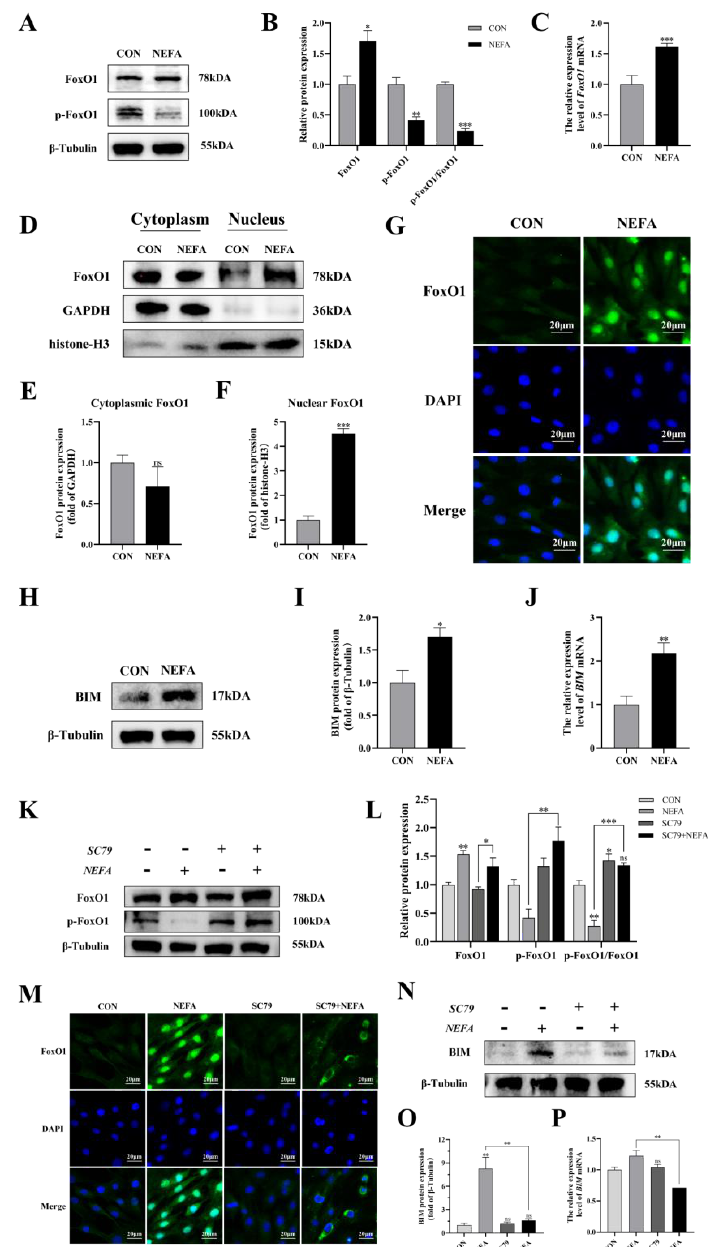
Figure 9. Regulation of FoxO1 levels, activity, and translocation by NEFA and AKT activator SC79 in BGCs. Experiments of ( A – J ): BGCs were treated with or without 1.2 mM NEFA for 24 h. Experiments of ( K – P ) were performed after NEFA treatment of BGCs for 24 h with or without SC79 pretreatment for 2 h. ( A – C , K , L ) Protein levels of FoxO1 and FoxO1 phosphorylation (Ser256) were analyzed by Western blot and mRNA levels of FoxO1 were tested by qRT − PCR. ( D – F ) Western blot results and analysis of FoxO1 in nucleus and cytosol. ( G , M ) Immunofluorescence staining of FoxO1 nuclear translocation Green: DCFH − DA, Blue: DAPI, scale bar: 20 µ m. ( H – J , N – P ) mRNA and protein expression of BIM. The quantification of the relative protein levels (performed using Image J) is shown under the band (protein/( β − Tubulin/GAPDH/histone − H3)). This experiment was repeated 3 times, and data are expressed as mean ± standard errors of the mean (SEM), * p < 0.05; ** p < 0.01; *** p < 0.001; ns, not